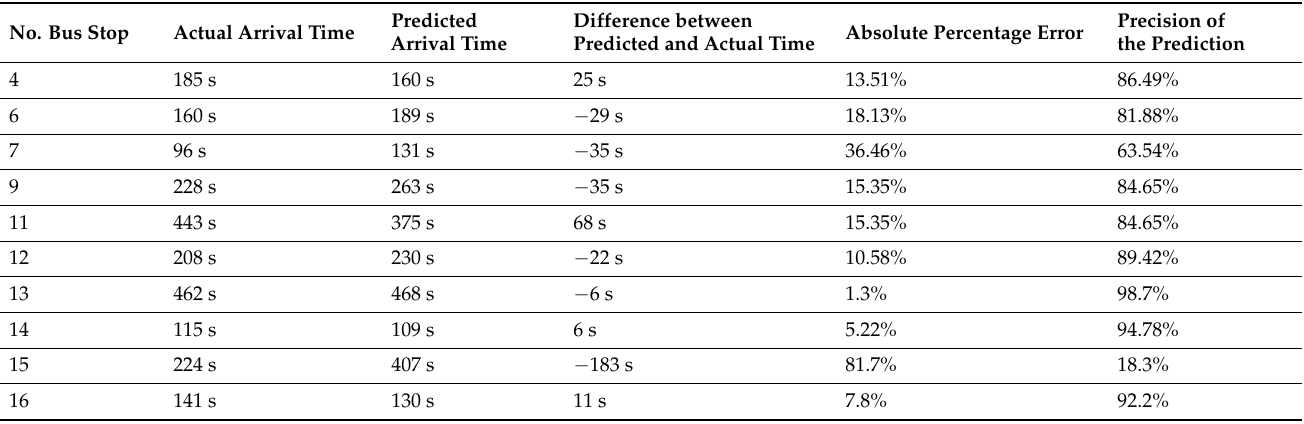
Table 5. Results obtained for Trip 5, Journey: Guacamayas–University. MAE = ± 42 s, MAPE = 20.5% Precision = 79.5%.